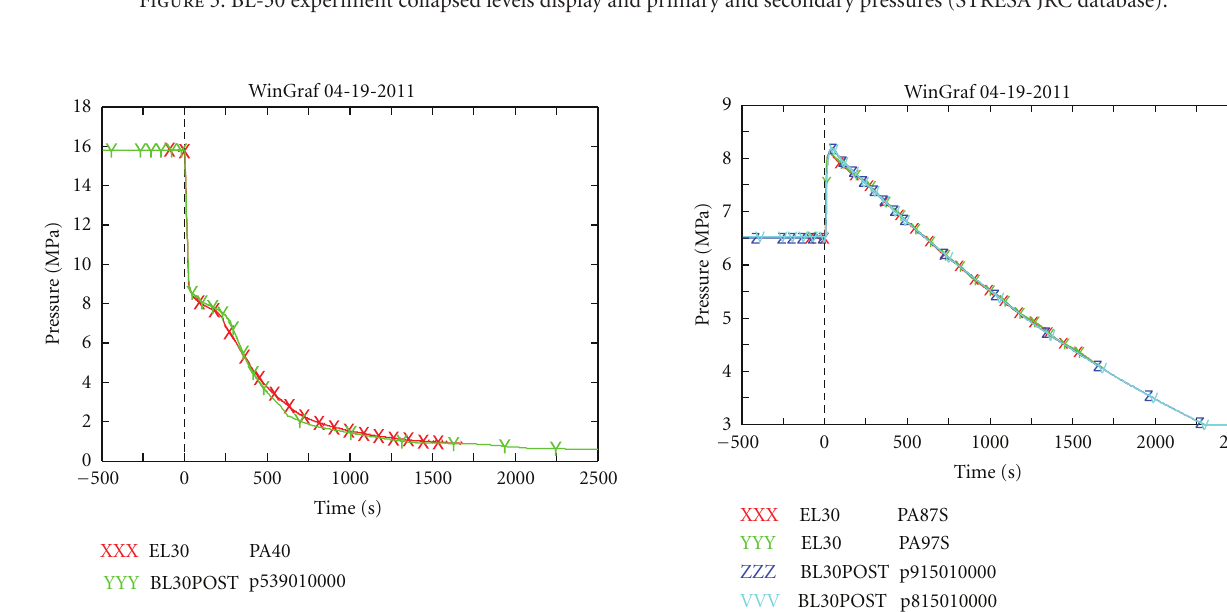
temperatures decrease due to the combined e ff ect of